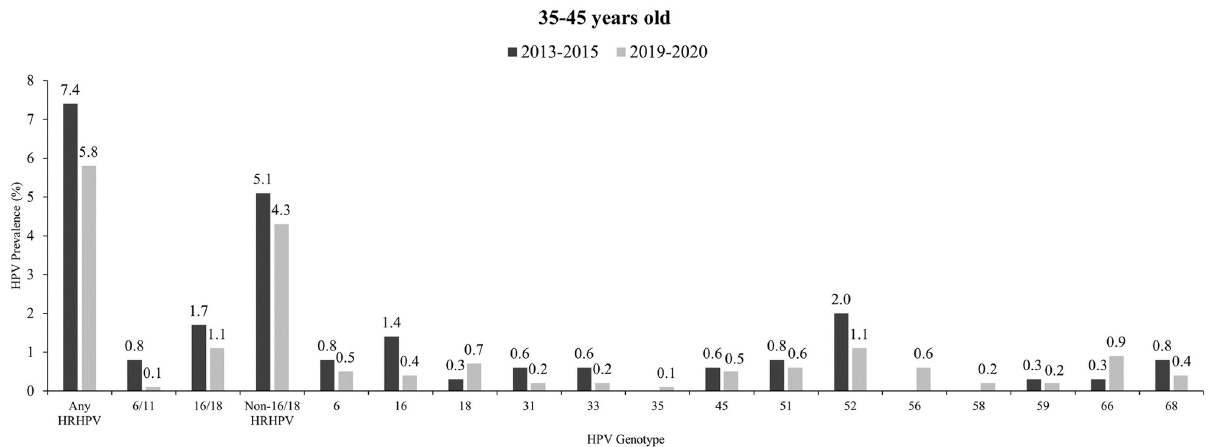
Fig 2. Distribution of HPV genotypes among women aged 35–45 across two study periods. Other than HPV52, vaccine-targeted HPV genotype such as HPV18 remained on of the most frequently detected HPV genotypes across both study periods. Abbreviations: CI, confidence interval; HPV, Human papillomavirus. HPV11 and HPV39 infections were not reported among women aged 35–45 across both study